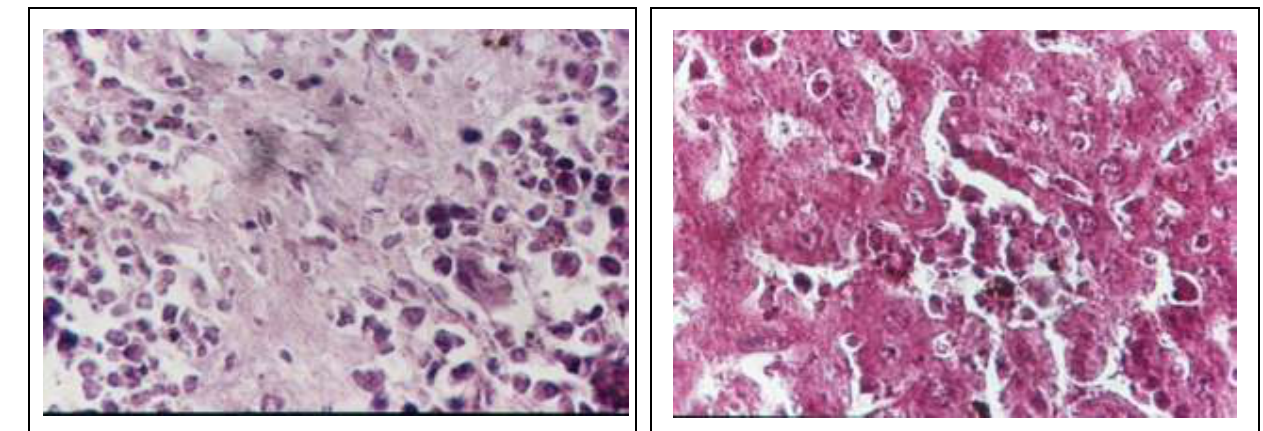
Fig 8 Section of liver in a mouse (from group B)Sub group I showed deposits of amyloid in peri lymphoid group II , show hepatic cell glycogenic infiltration and follicle of white pulp (H and E stain) mononuclear cells infiltration (PAS, X 40 ).